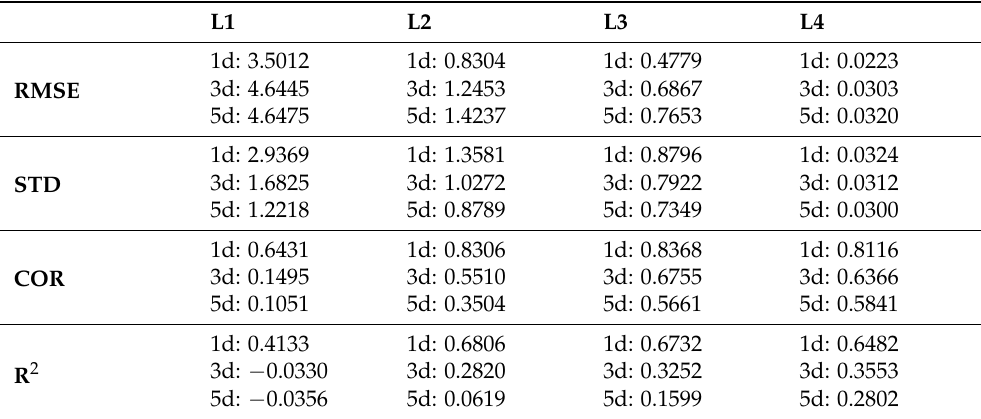
Table 2. Values of RMSE , STD , COR, and R 2 at the four points for different output lengths. Here, 1d indicates the forecast results for one day backward, 3d indicates the forecast results for three days backward, and 5d indicates the forecast results for five days backward.